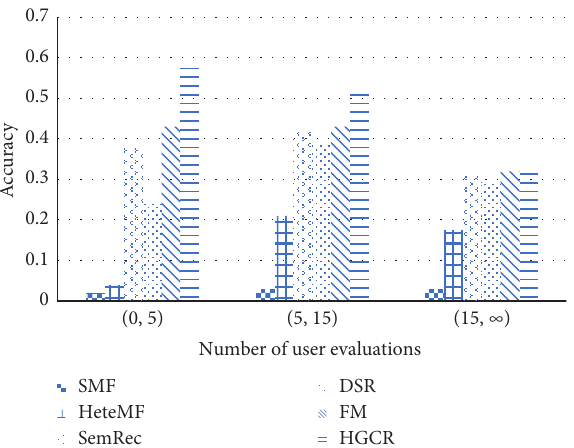
Figure 12: Performance of cold start on Yelp.